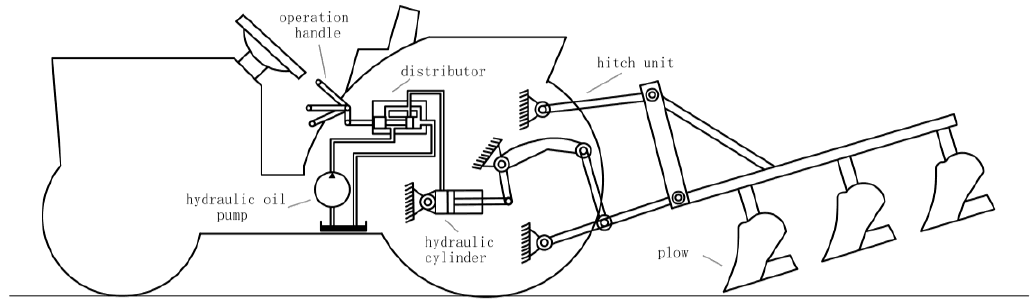
Figure 1. The structure principle of the traditional mechanical hydraulic hitch system.